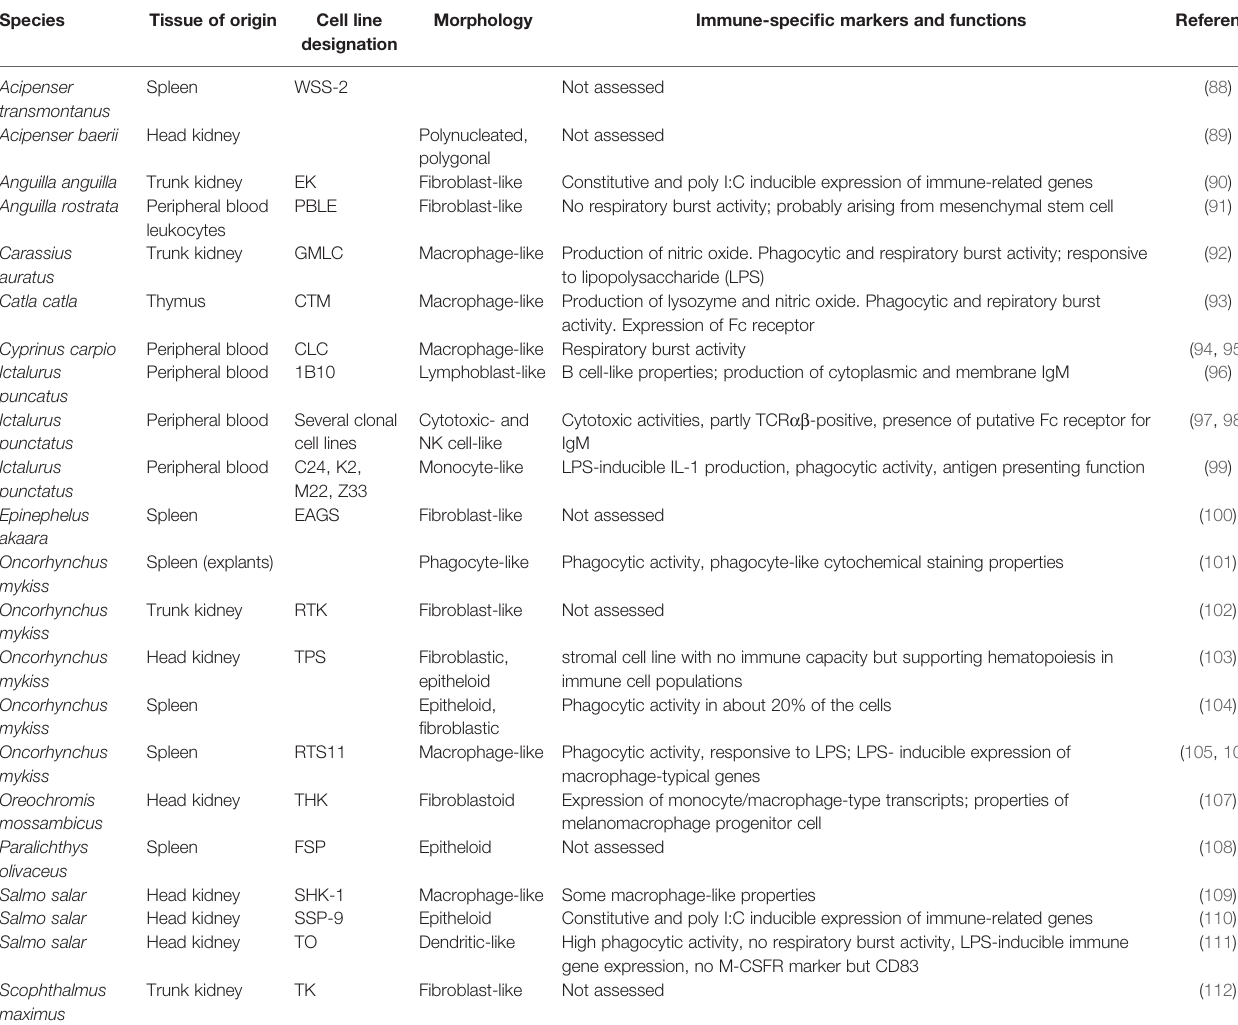
TABLE 1 | Examples of fi sh cell lines derived from immune tissues.